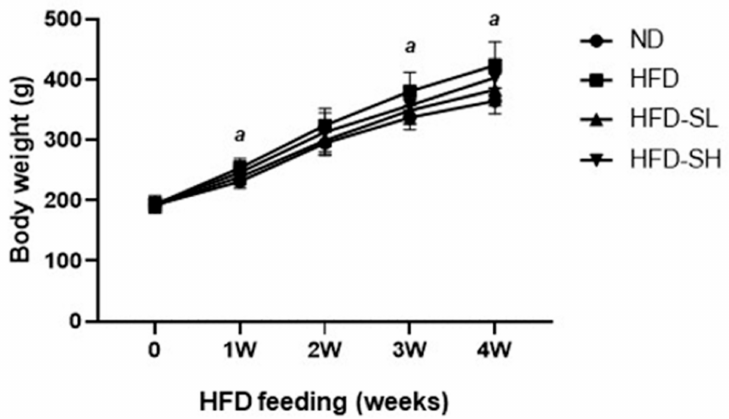
Figure 3. E ff ect of Spergularia marina powder (SMP) supplementation on body weight gain under high-fat diet (HFD) feeding. Rats were fed a normal diet or high-fat diet with / without the Spergularia marina Griseb powder supplement for 4 weeks. The rat body weights were measured every week. ND, Normal diet; HFD, High-fat diet; HFD-SL, High-fat diet + 3% of Spergularia marina Griseb; HFD-SH, High-fat diet + 5% of Spergularia marina Griseb. Values are means ± SDs, n = 8. Data were analyzed